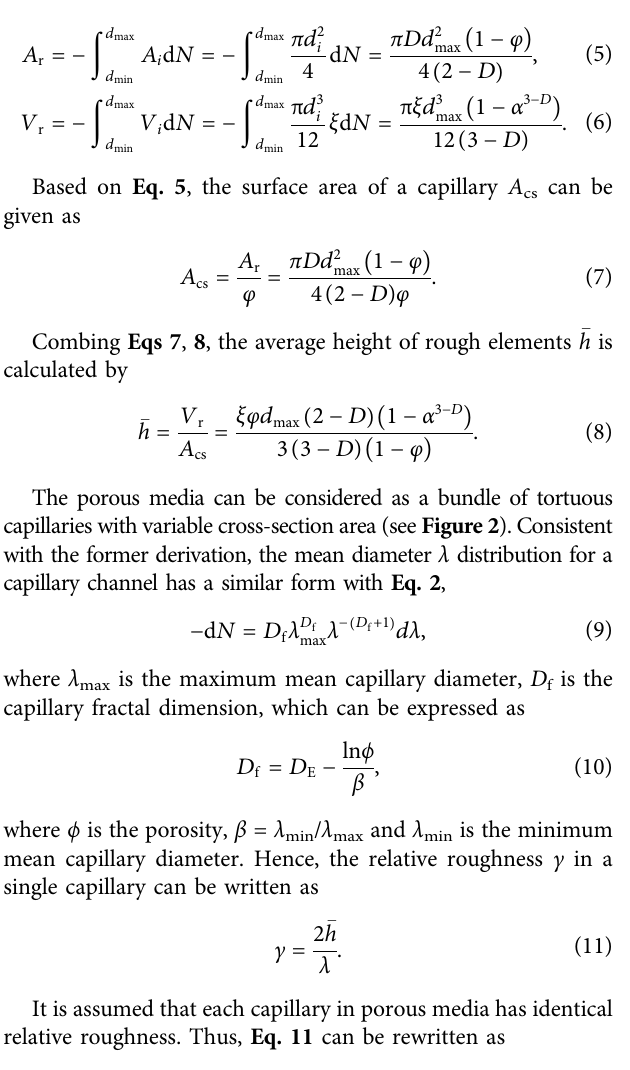
Frontiers in Earth Science |